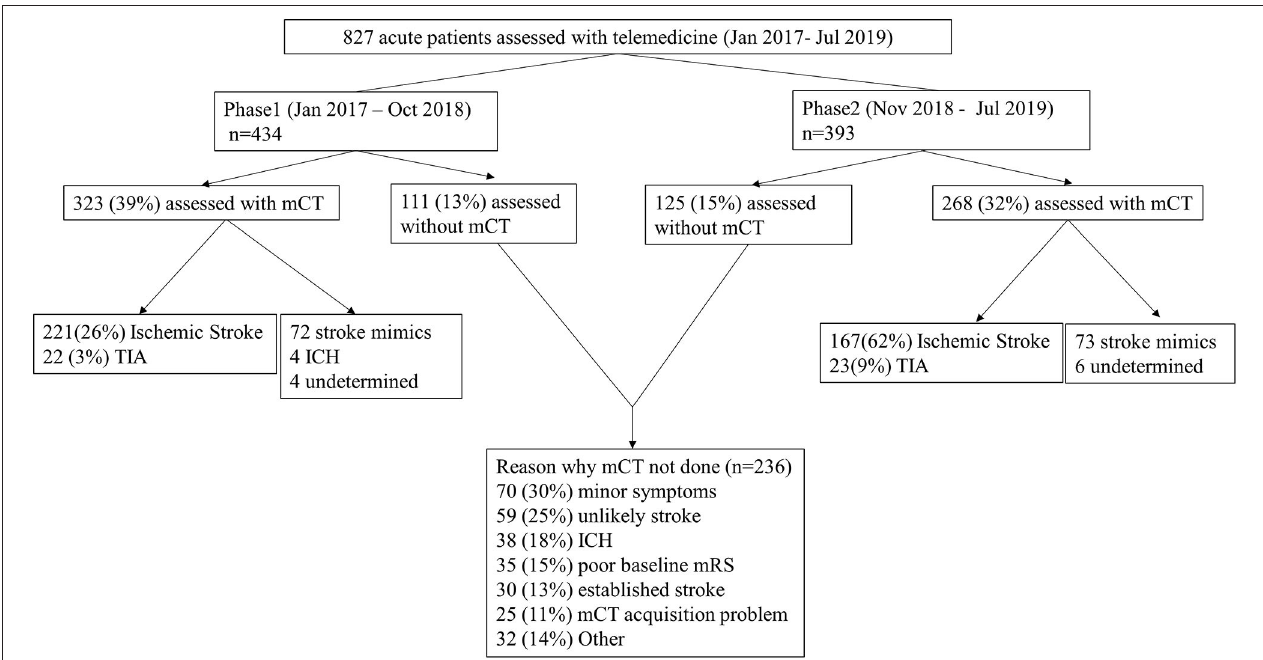
FIGURE 1 | Diagnoses in each phase and the reasons why mCT was not used. mCT, multimodal Computed Tomography (CT); TIA, Transient Ischemic Attack; ICH, Intracranial Hemorrhage; NCCT, non-contrast CT; mRS, modified Rankin Scale.